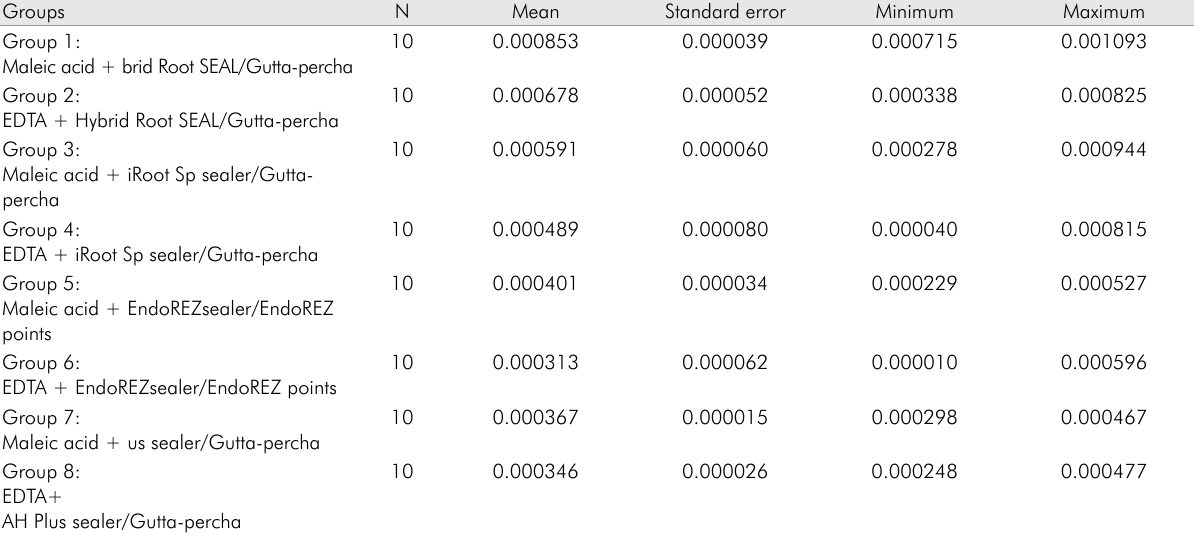
Table 2. Mean, standard error, minimum, and maximum microleakage values of the groups Groups N Mean Standard error